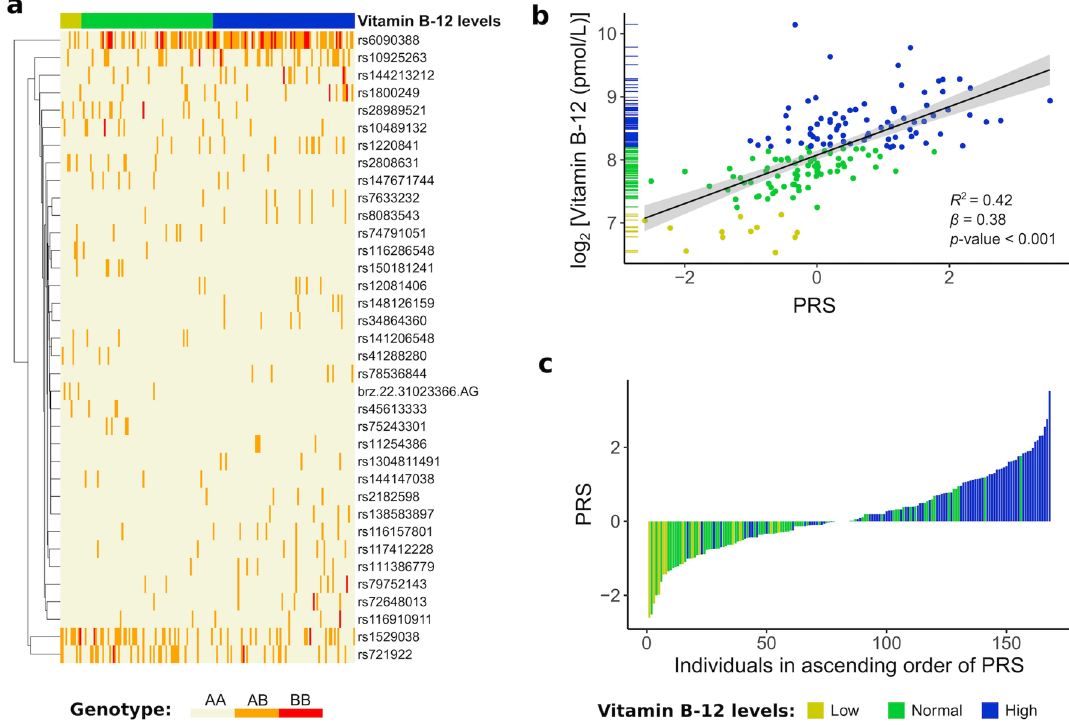
Figure 2. Heatmap of 36 variants associated with baseline vitamin B12 levels. BB is minor allele ( a ). PRS regression to vitamin B12 levels ( b ). Individuals in ascending order of PRS ( c ).